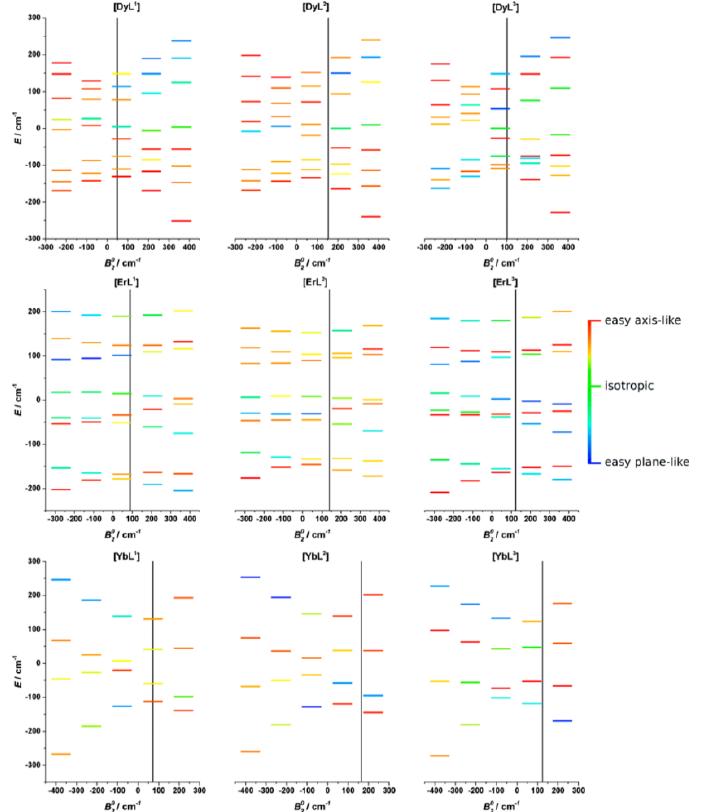
Figure 9. Changes in the energies of the ground state J multiplets for [DyL 1 − 3 ], [ErL 1 − 3 ], and [YbL 1 − 3 ] in response to the variation of the axial crystal field parameter B 0 . The color code indicates the degree of axiality (toward easy-axis or easy-plane) in the principal g-values anisotropy for each Kramers doublet. Energies are referenced to the barycenter for each parameter set. Vertical lines correspond to the B 0 value obtained from CASSCF-SO calculations based on XRD data. Reprinted with permission from ref. [114], copyright 2019 American Chemical Society.